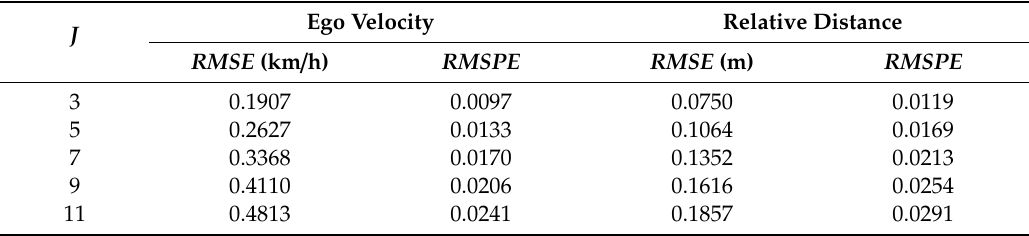
Table 2. Model accuracy with di ff erent value of J .